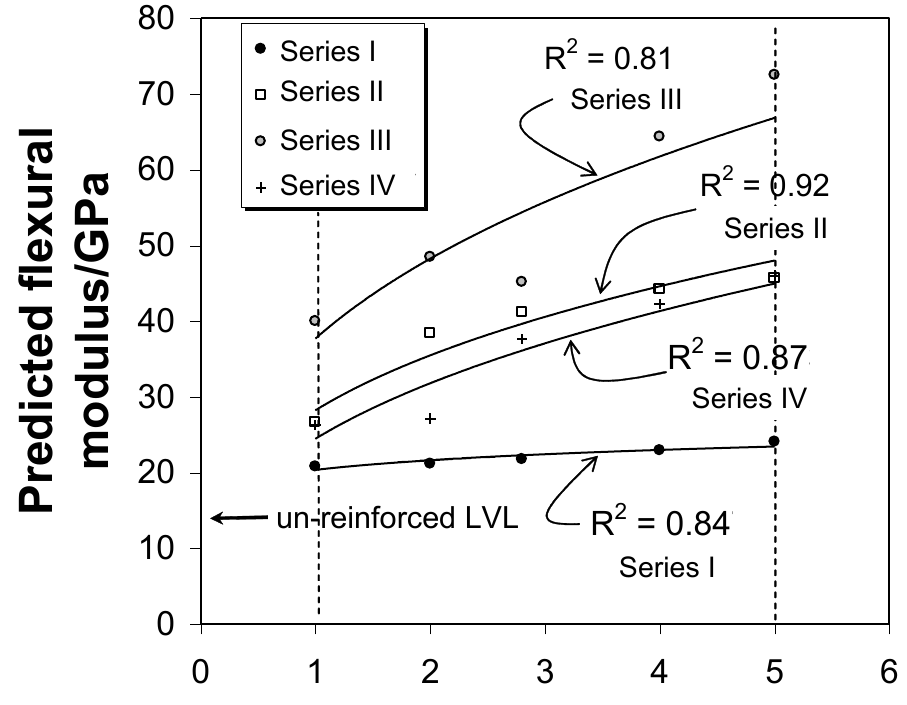
Figure 12. Finite element model predictions for the flexural modulus plotted as a function of the reinforcement volume fraction for series I-IV steel-LVL composite